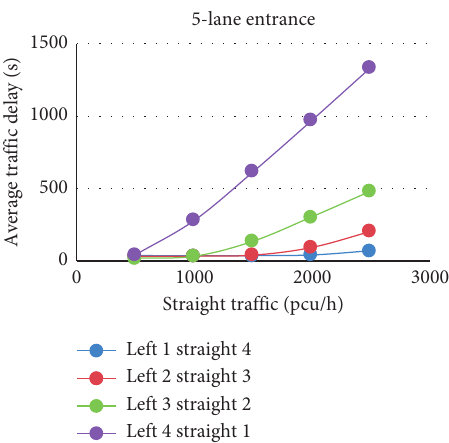
Figure 9: Change in the straight direction delay under different combinations of lanes on five entrance